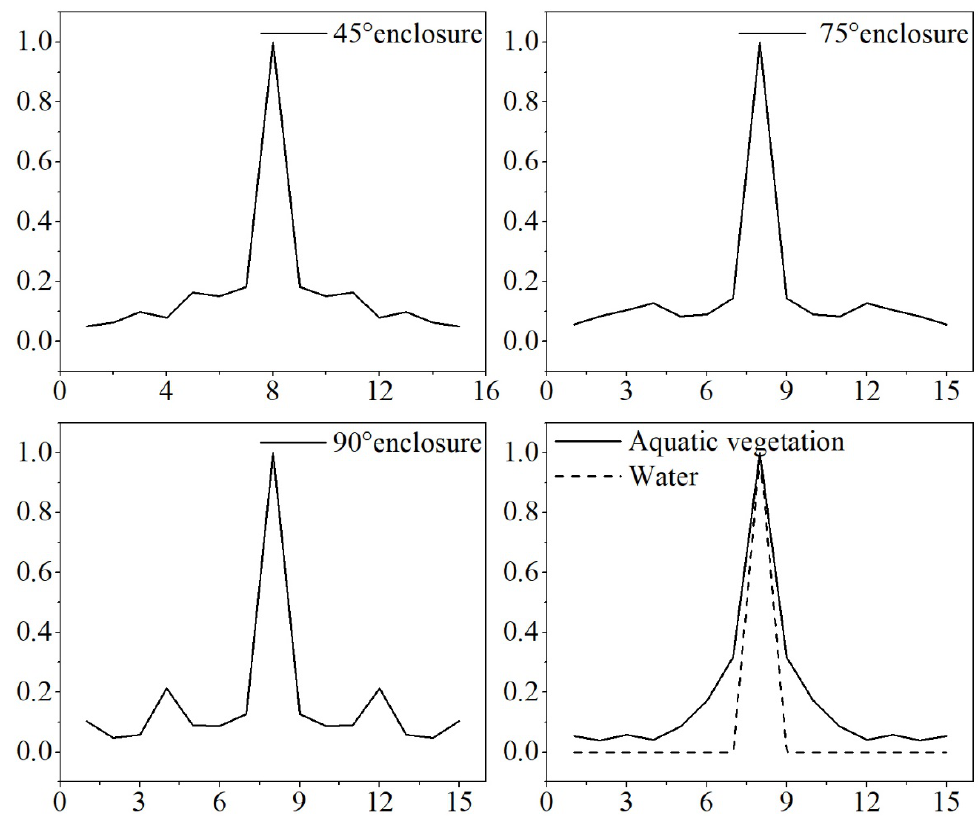
Figure A3. One-dimensional projections of FFT2 for 45 ◦ , 75 ◦ and 90 ◦ pens, aquatic vegetation and water. Note that the 45 ◦ , 75 ◦ and 90 ◦ enclosure represent the angles between pen facility and horizontal line. A pen facility area had distinct and periodical features compared with water and aquatic vegetation.